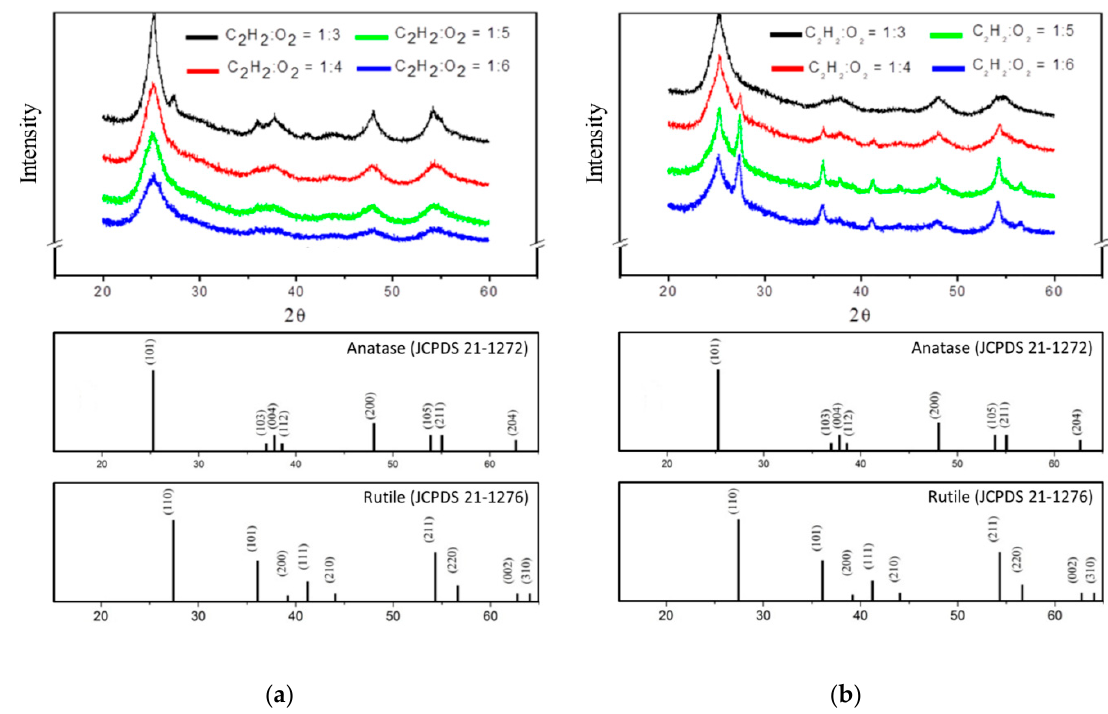
Figure 1. XRD spectra of TiO 2 powders produced by a flat-flame chemical vapor condensation (FFCVC) method using various acetylene / oxygen flow ratios (C 2 H 2 / O 2 ). The acetylene flow rates (C 2 H 2 ) are ( a ) C 2 H 2 600 sccm and ( b ) C 2 H 2 800 sccm.